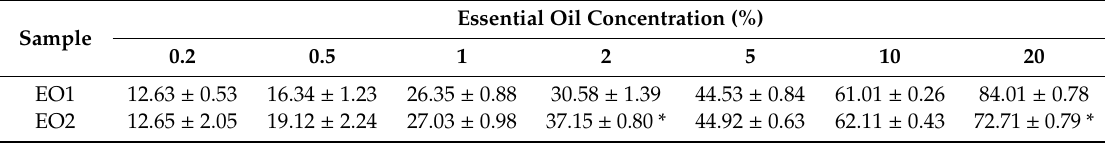
Table 1. Antioxidant activity of nutmeg essential oils applied at di ff erent